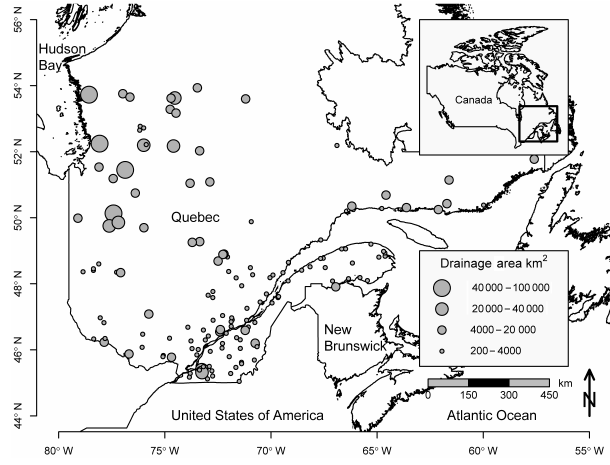
Figure 3. Location of the 151 hydrometric stations in southern Québec,